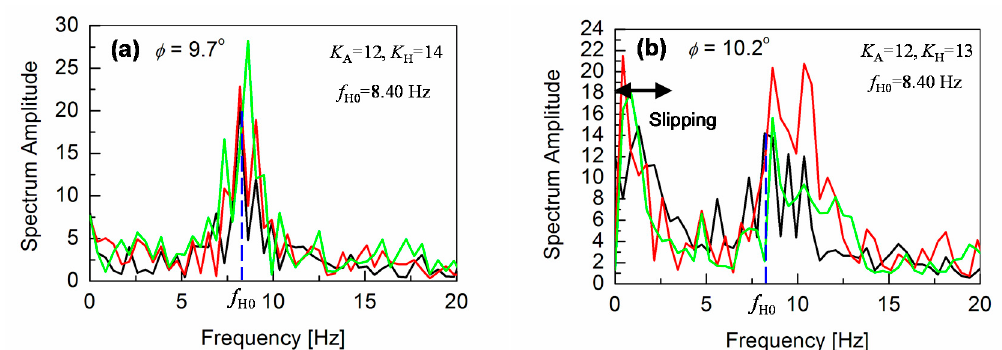
Figure 9. Fourier transformation of the angular-pitch velocity, when both ankle-pitch and hip-pitch motors are controlled by the gyro sensor for φ = 9.7° (see ( a )) and φ = 10.2° (see ( b )). It can be seen that the contribution due to the fundamental walking frequency of 1.73 Hz is no more observable. Instead, a peak at higher frequency is observed. The measured time-domain waveform becomes more oscillatory, as shown in Figure 7.